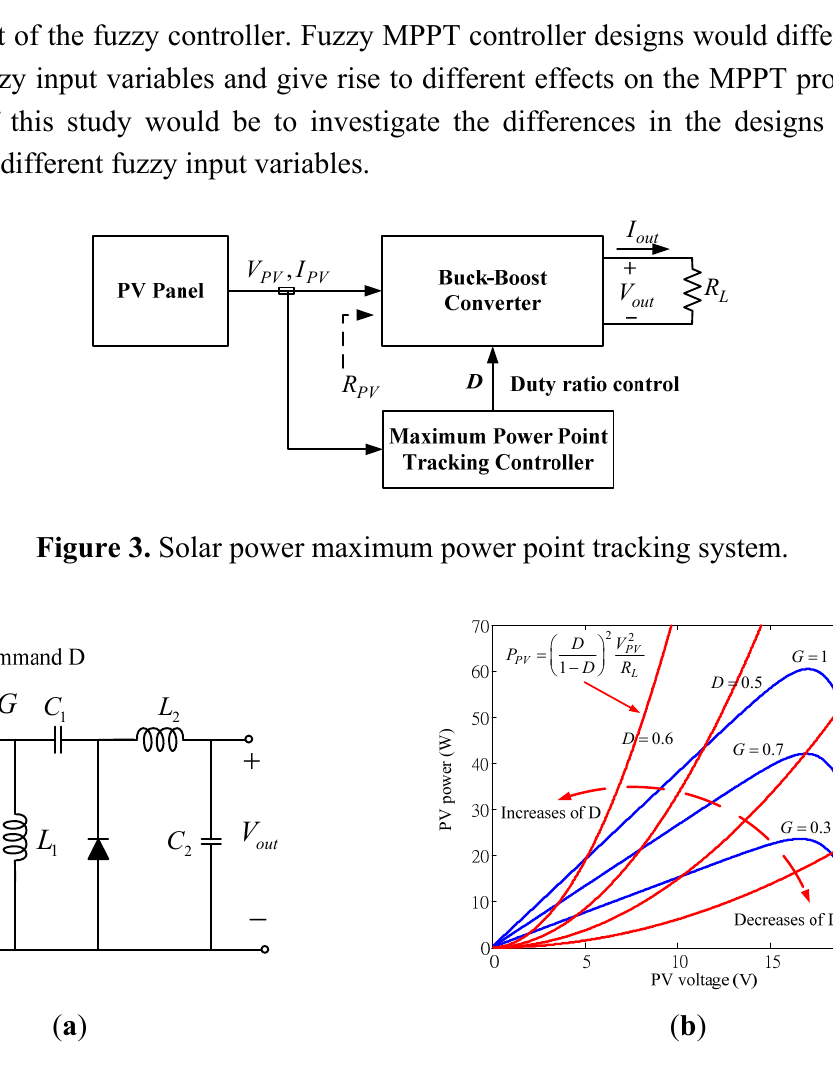
Figure 4. ( a ) Zeta type buck-boost converter; ( b ) PV power characteristics.